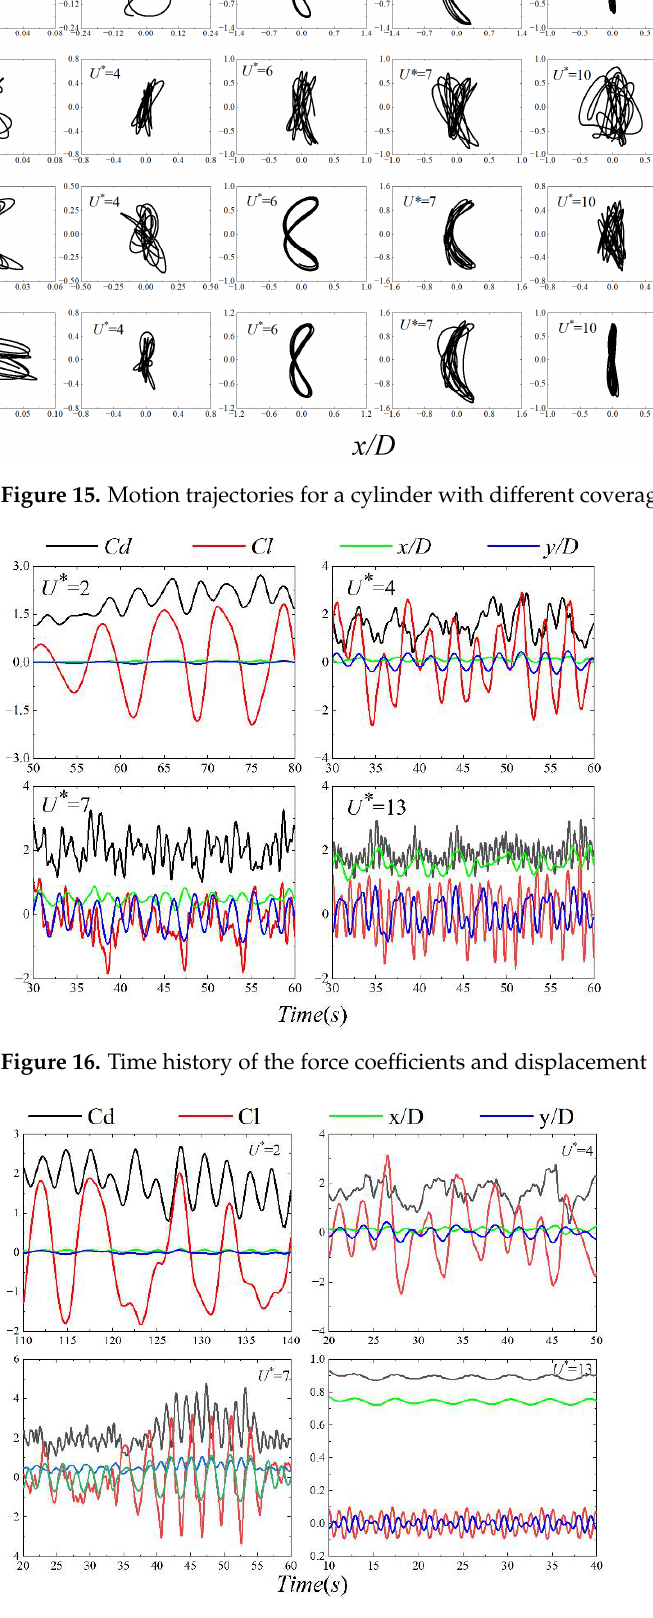
Figure 18. Time history of the force coefficients and displacement for CR 40.